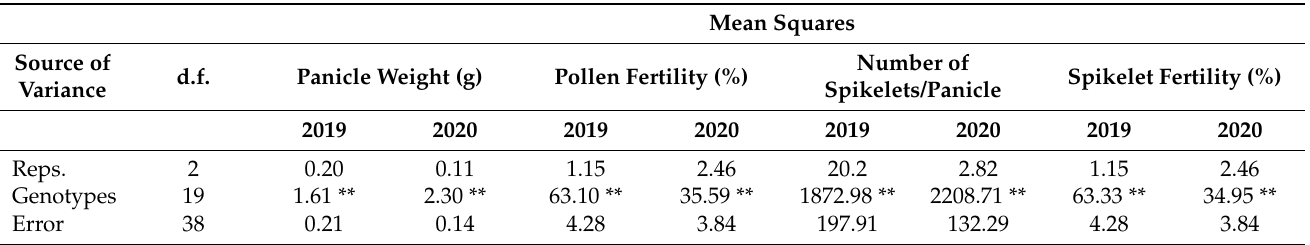
Table 3. Analysis of variances of panicle weight, pollen fertility percentage, number of spikelets /panicle and spikelet fertility percentage of twenty rice genotypes over two years.